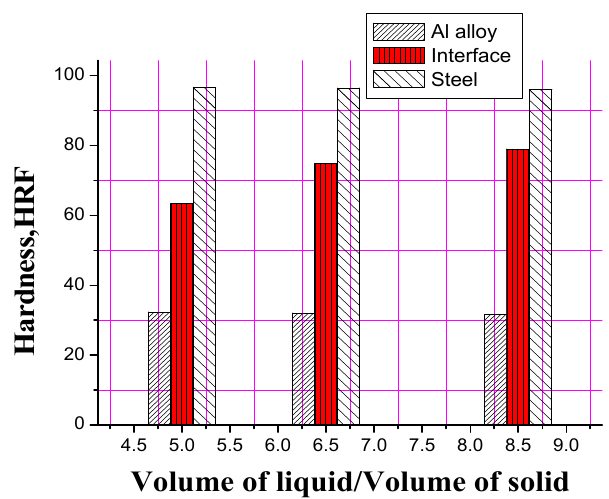
Figure 11. Effect of volume of liquid aluminum to solid steel substrate on interfacial hardness of 1:10 Sn: flux tinned steel substrate.